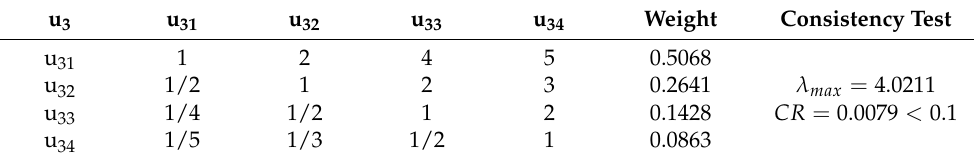
Table 10. The judgment matrix and weights of evaluation indicators under u 3 .